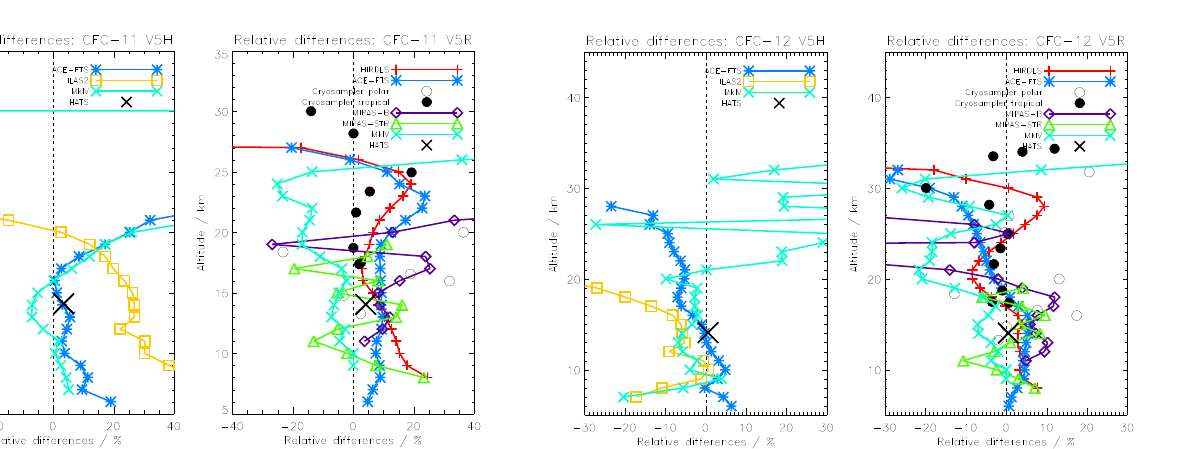
Figure 31. Relative differences between MIPAS CFC-12 for the FR (left) and RR (right) period and each comparison instrument, × calculated as MIPAS − Other MIPAS